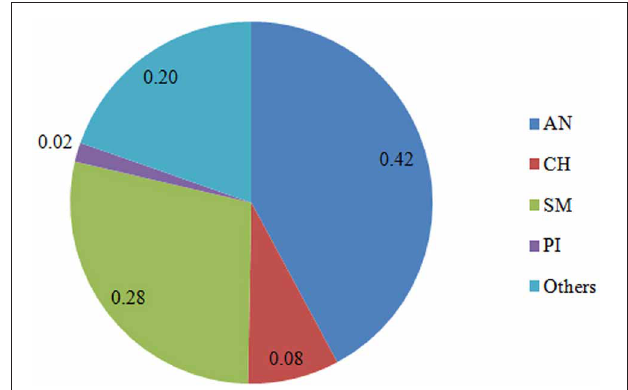
FIGURE 1 | Breed composition (%) of the crossbred animals genotyped. AN, Angus; SM, Simental; PI, Piedmontese; CH, Charolais; Others, 15 other